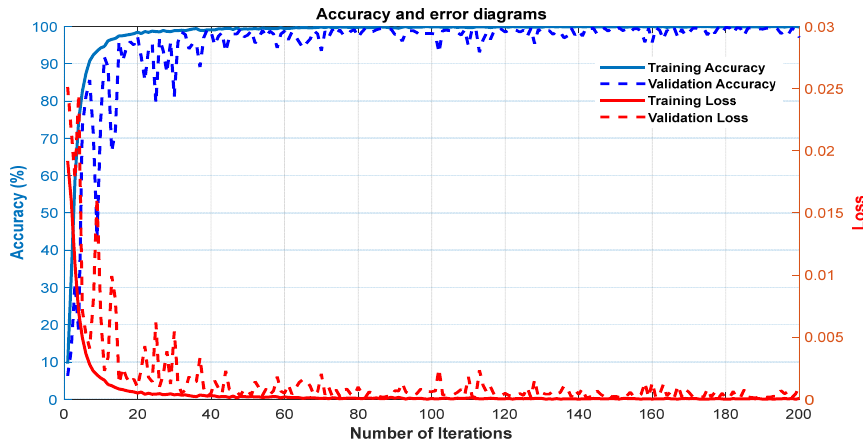
Figure 7. The accuracy and error plots of the proposed customized CNN model.